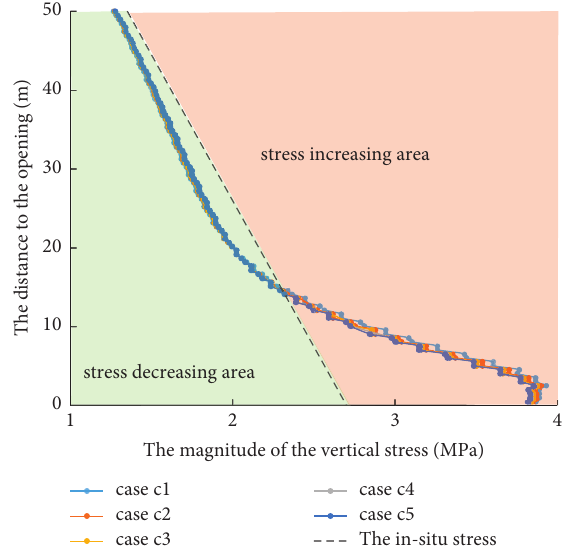
Figure 9: The relationship between the vertical stress and the distance to the opening.